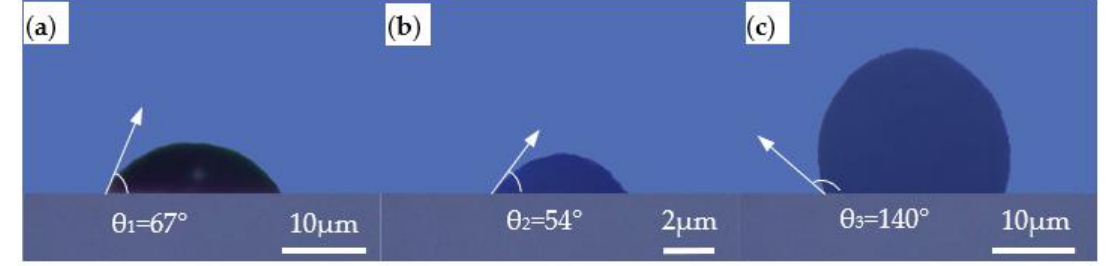
Figure 9. Contact angles of different materials at 20 °C: ( a ) MC-Wax; ( b ) PCL; ( c ) PMMA.